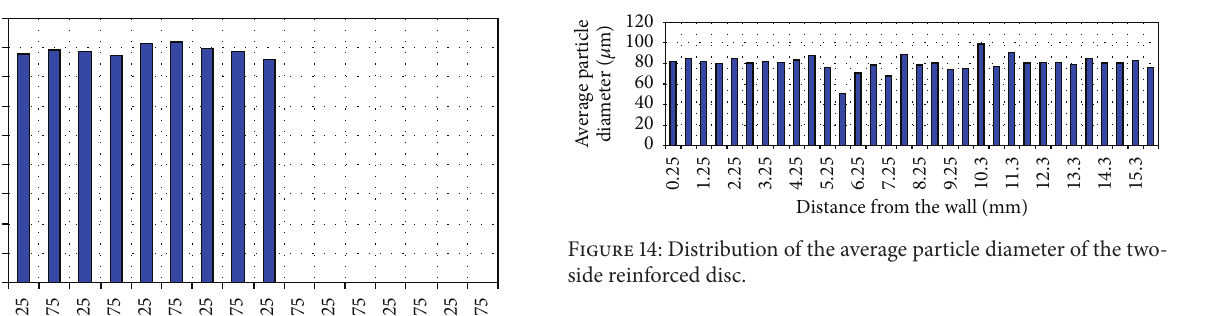
Figure 13: Distribution of the volume fraction of reinforcement of the two-side reinforced disc.